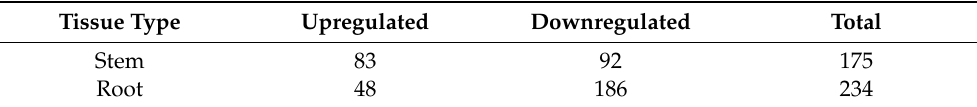
Table 2. Number of upregulated and downregulated differentially expressed genes identified in stem ( Citrus sinensis (L.) Osbeck) and root tissues ( C. trifoliata (L.)). Tissue Type Upregulated Downregulated Total Stem 83 Root 48 186 234 Heat maps of the top 50 DEGs identified from the stem and root tissues of non-infected and CDVd-infected trees were generated based on FDR (Figure 4). Results indicated a relatively even clustering of stem upregulated and downregulated DEGs in the non-infected and CDVd-infected samples. In contrast, the roots showed clustering skewed towards the DEGs that were significantly downregulated in the CDVd-infected and upregulated in the non-infected samples (Figure